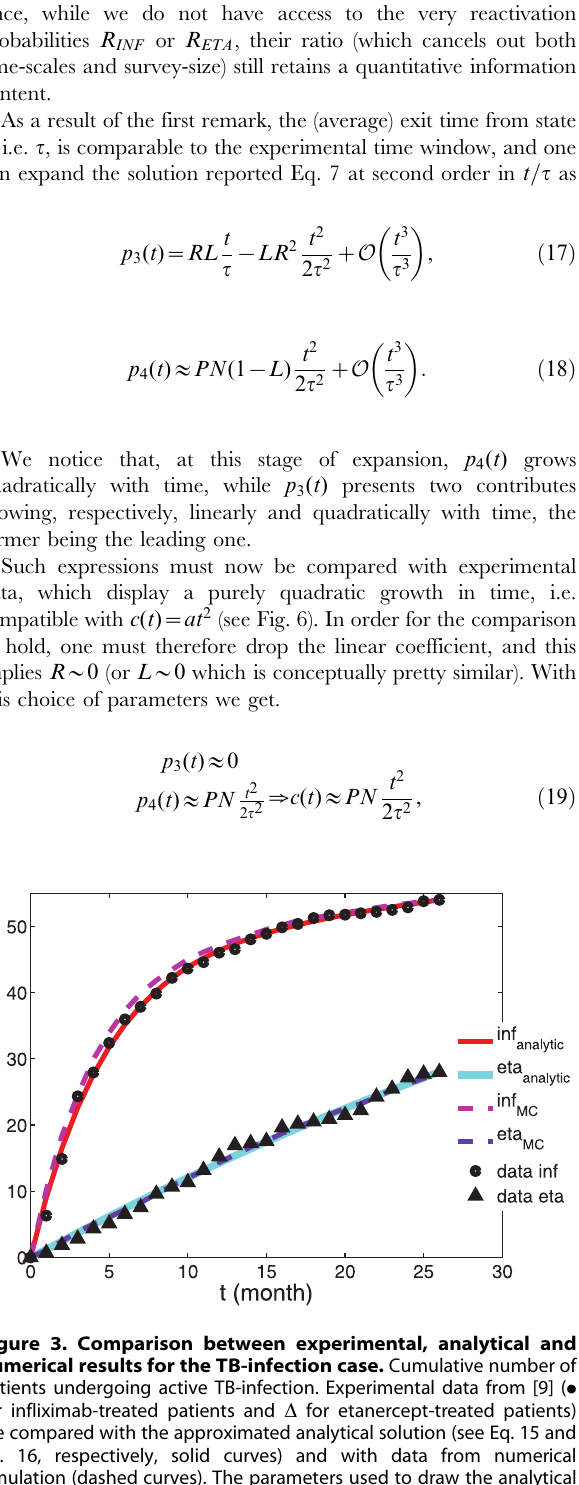
number of patients participating to the screening, consequently, Table 1. TB-infection case: Best-fit coefficients.